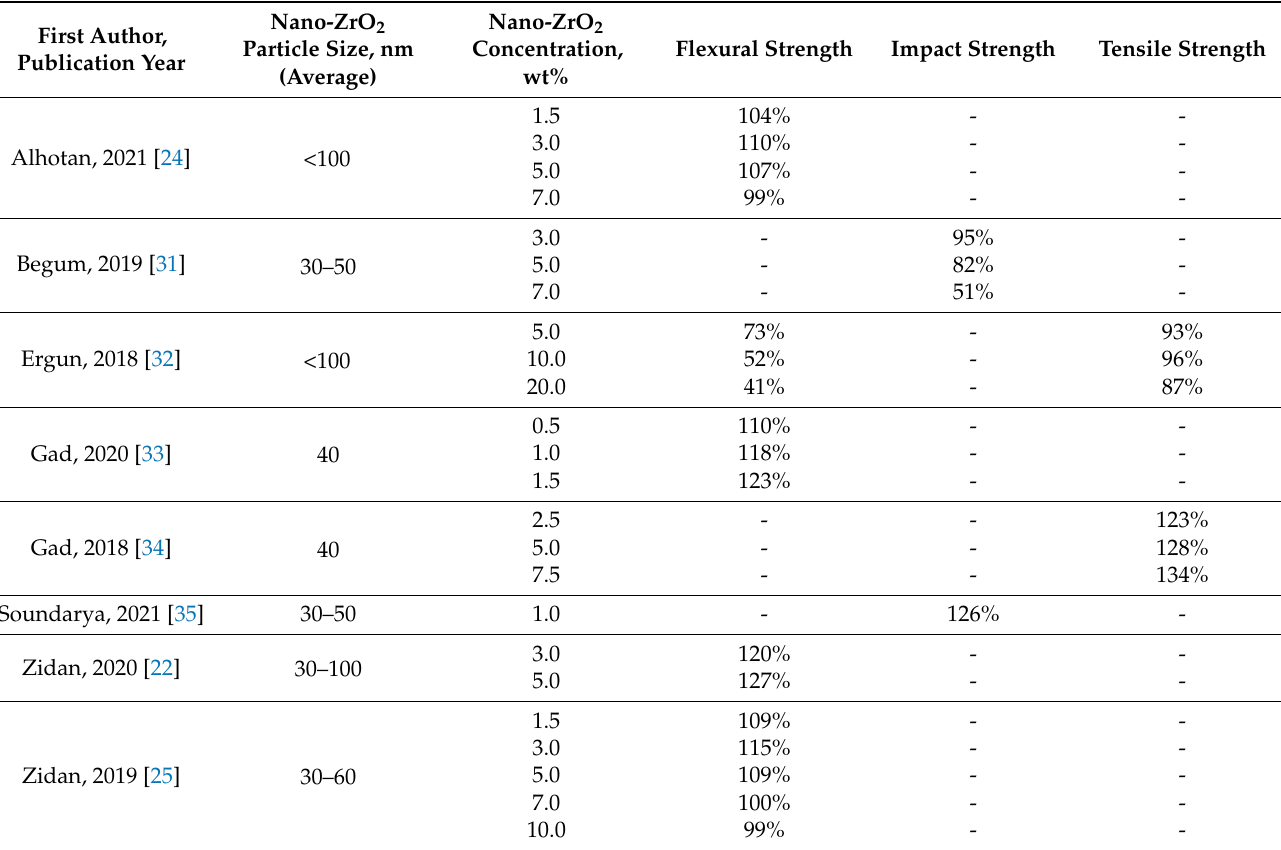
Table 3. Summary of the studies qualified for the meta-analysis. For individual types of durability, the percentage strength in relation to the reference value obtained in the test for PMMA without nanofiller is